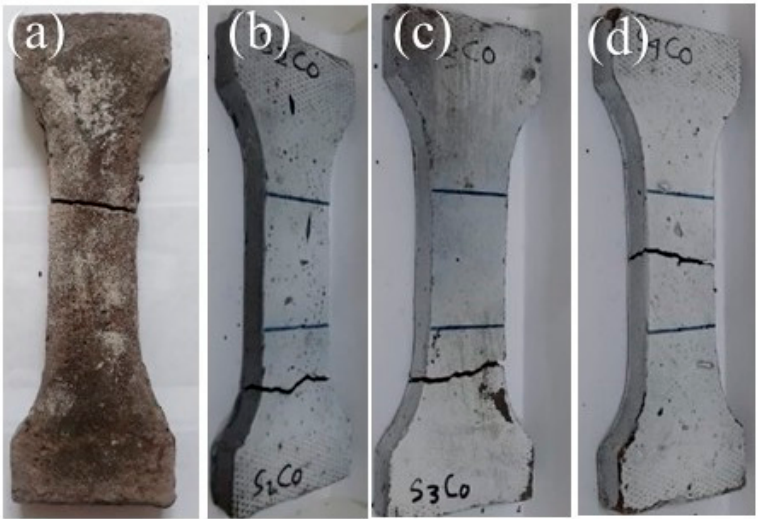
Figure 5. Crack condition after direct tensile strength test ( a ) 0 wt% nanosilica, ( b ) 2 wt% nanosilica, ( c ) 3 wt% nanosilica, ( d ) 4 wt% nanosilica.